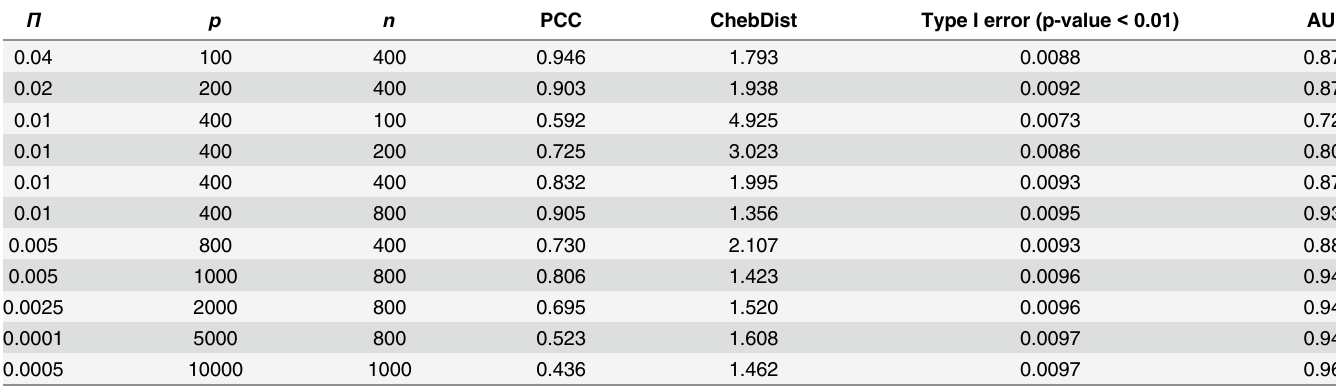
Table 1. Performance of estimating the precision